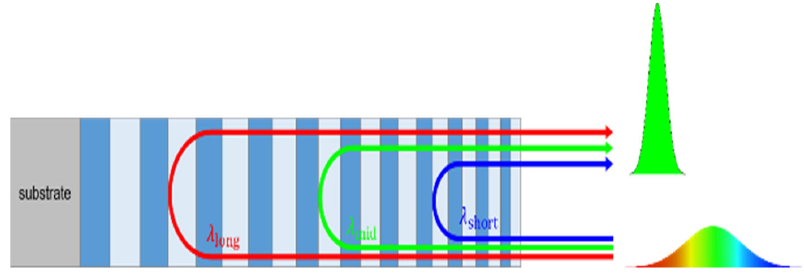
Figure 1. Schematic of the concept for chirped mirrors.